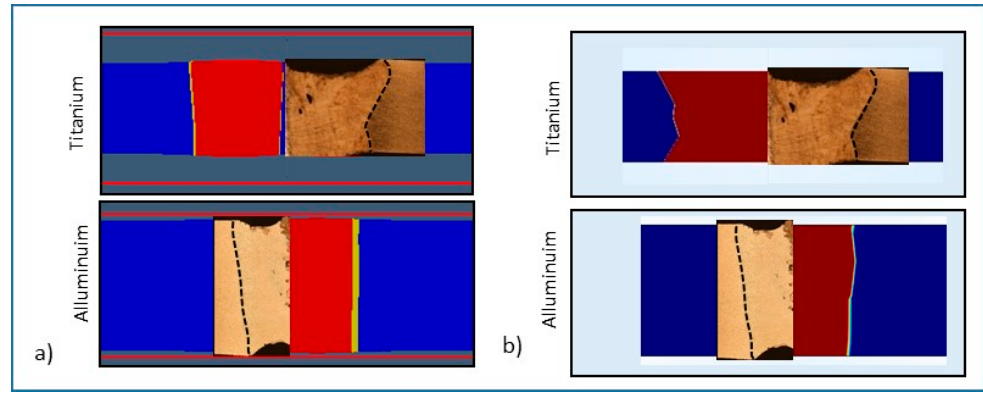
Figure 10. Calibration of ( a ) 3D and ( b ) 2D heat source models by the cross section of the weld. In Tables 5 and 6, the dimensions of the fusion zone profile, respectively, in the top, middle and bottom, are reported both for 2D and 3D numerical simulation and the experimental measure. A better